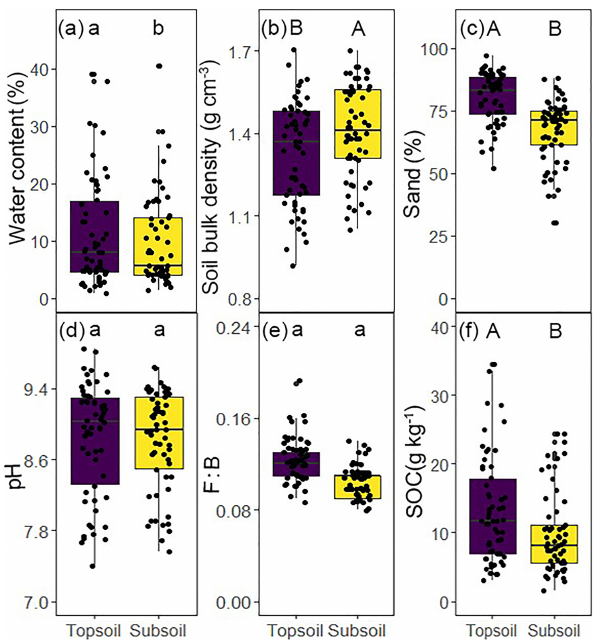
Figure 1. Basic characteristics of study sites across the Inner Mon- golian grassland at different soil depths. Different letters indicate significant differences between soil depths on log10-transformed data (paired t test, lowercase letter, P < 0 . 05; uppercase letter, P < 0 .